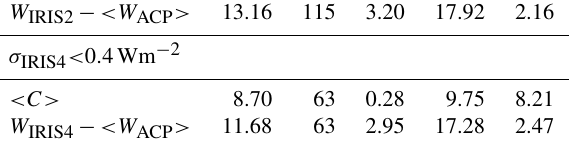
Figure 6. ACP96 <C> values derived using the new equation us- ing the linear LSQ method with ε c = 0 . 0225 and γ = 6 . 5 for 244 calibration periods in 2020.